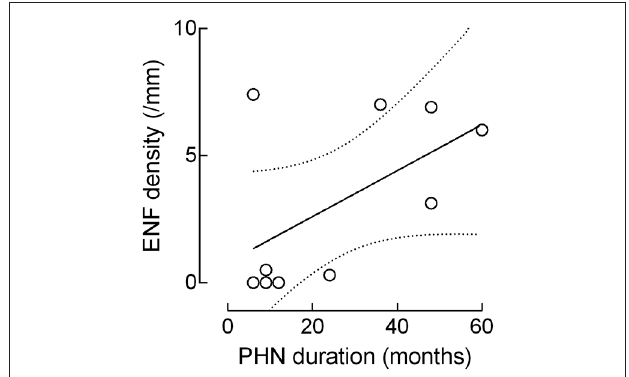
FIGURE 4 | Correlation between epidermal nerve fiber (ENF) density and PHN duration. Although the ENF density increased with the PHN duration, this correlation missed the statistical significance (epidermal nerve fiber: r : 0.5574, p =